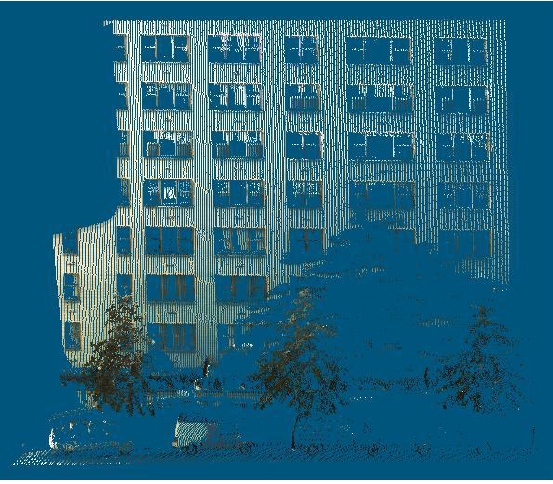
3D Urban Data Challenge 2011, image # ParkAvenue SW12 piece07 [36]. (a)